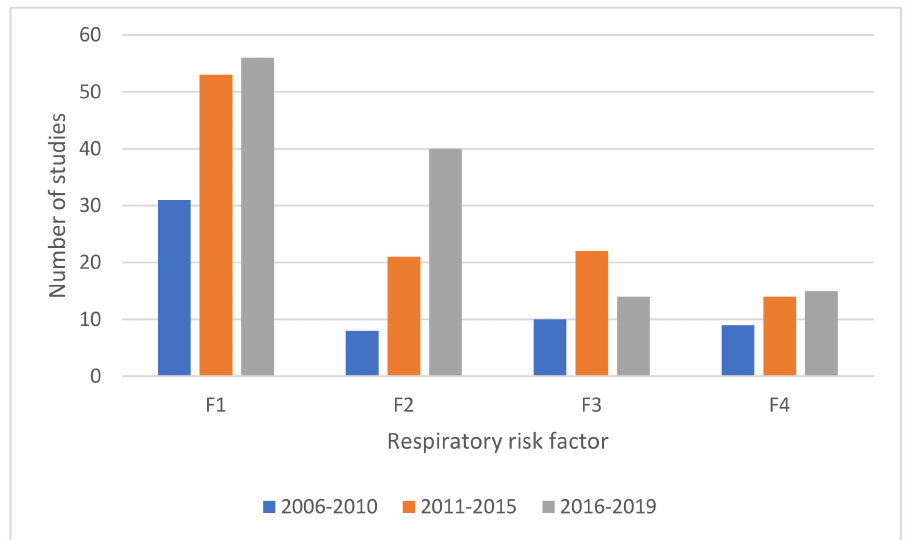
Figure 7. Evolution of most prevalent respiratory risk factors (F1–F4) over